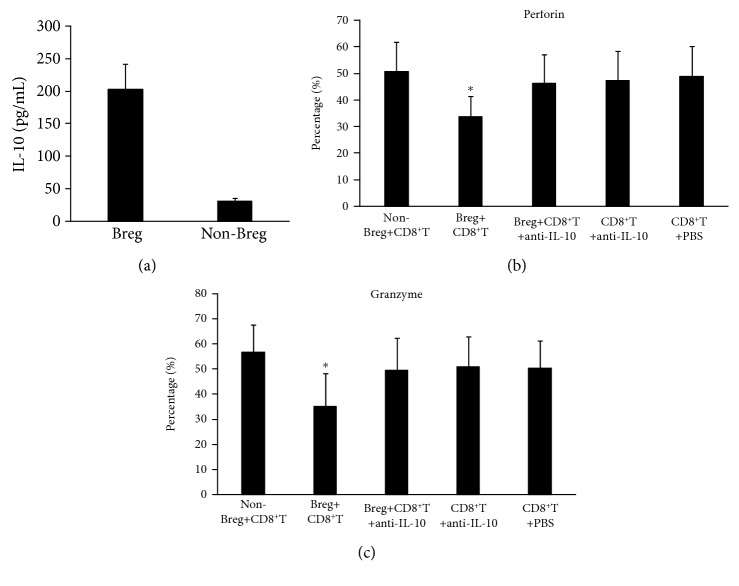
The inhibitory effect of Breg cells on CD8+ T cells. (a) Level of IL-10 in the culture supernatant of non-Breg and Breg cells after treatment with CpG. ∗P < 0.05 compared with the non-Breg group. (b) Perforin and (c) Granzyme level in non-Breg+CD8+T, Breg+CD8+T, Breg+CD8+T+anti-IL-10, CD8+T+anti-IL-10, and CD8+T+PBS groups. Breg+CD8+T group compared with other groups, ∗P < 0.05.